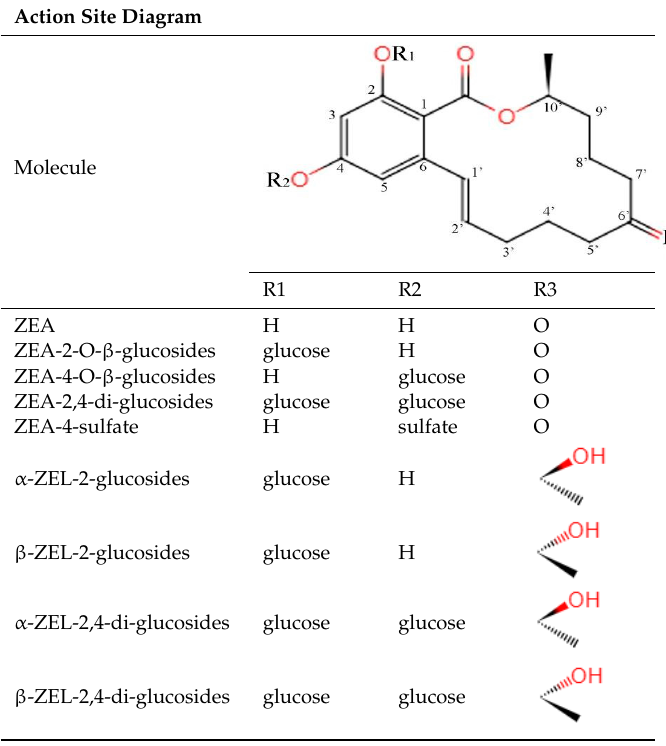
Figure 1. The formation pattern of secondary metabolites of zearalenone. ZEA: Zearalenone. α -/ β - ZEL: α -/ β -zearalenol. α -/ β -ZEL: α -/ β -zearalanol. 4.2.2. Modification of the Phenolic Hydroxyl Groups in ZEA